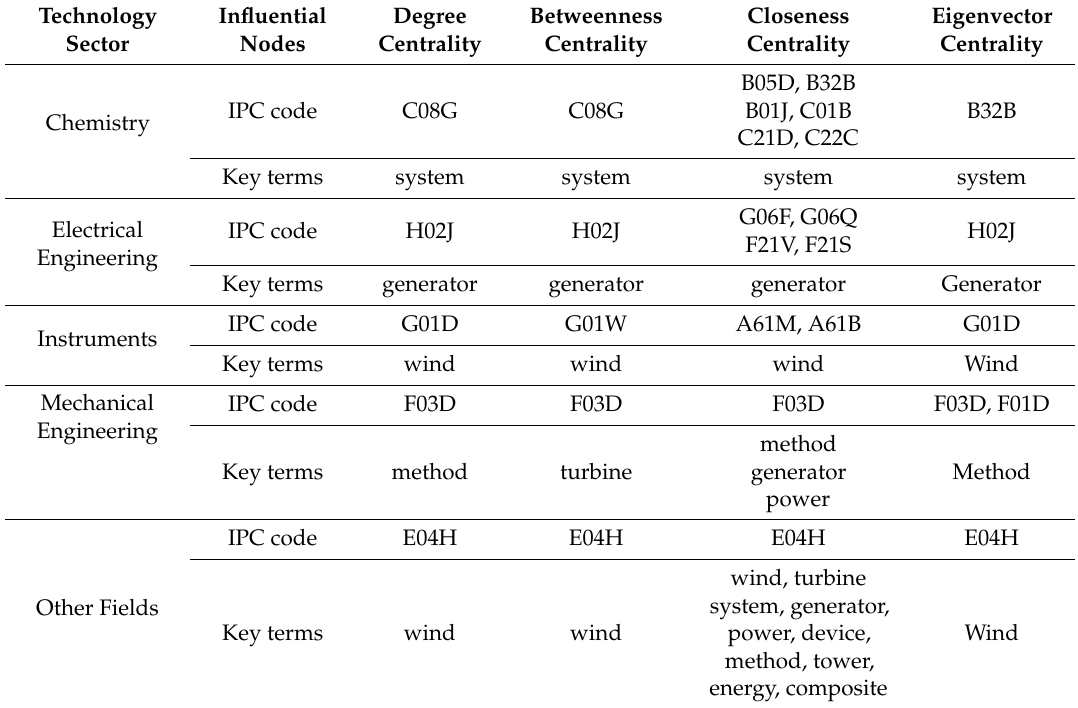
Table 9. Results of Social Network Analysis (SNA).